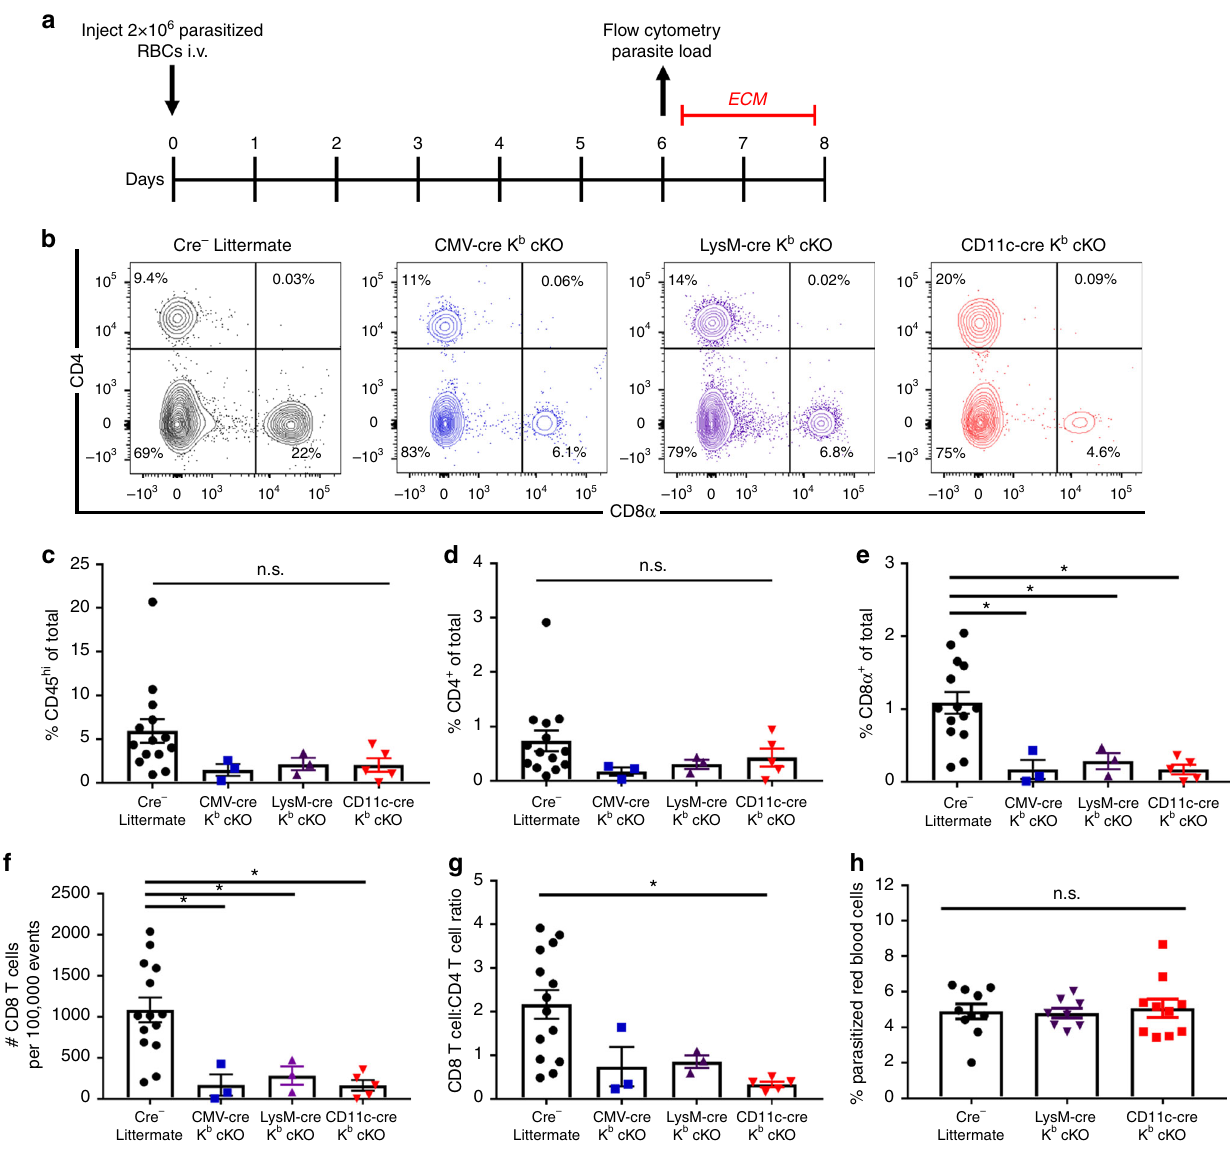
Fig. 4 Dendritic cells and macrophages generate discrete CD8 + T-cell responses in cerebral malaria. a Timeline of infection and readout with Plasmodium berghei ANKA. b Representative fl ow plots and c − g quanti fi cation demonstrate a reduction proportion and number of brain-in fi ltrating CD8 + T cells, but not CD45 hi immune cells or CD4 + T cells ( N = 14, 3, 3, 5 per group, respectively). h No difference in proportion of parasitized red blood cells was found between cre-negative littermates and conditional knockout stains 6 days post infection ( N = 10, 8, 10 per group, respectively). Data presented as mean with error bars representing standard error of the mean (SEM). * denotes p < 0.05 by Mann − Whitney U Test or one-way ANOVA with Holm − Sidak